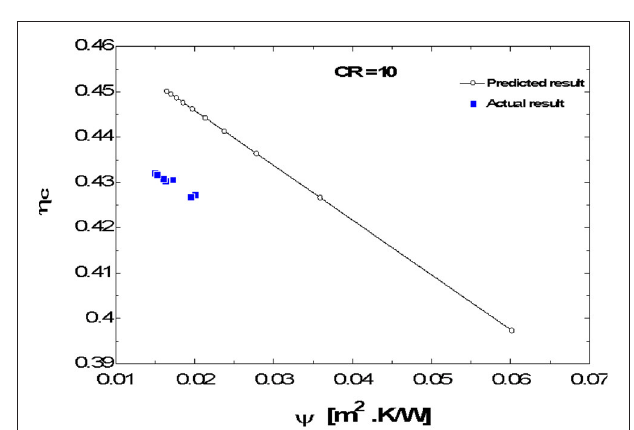
FIGURE 4 | Collector efficiency η c vs. insolation I s at different concentration ratios.